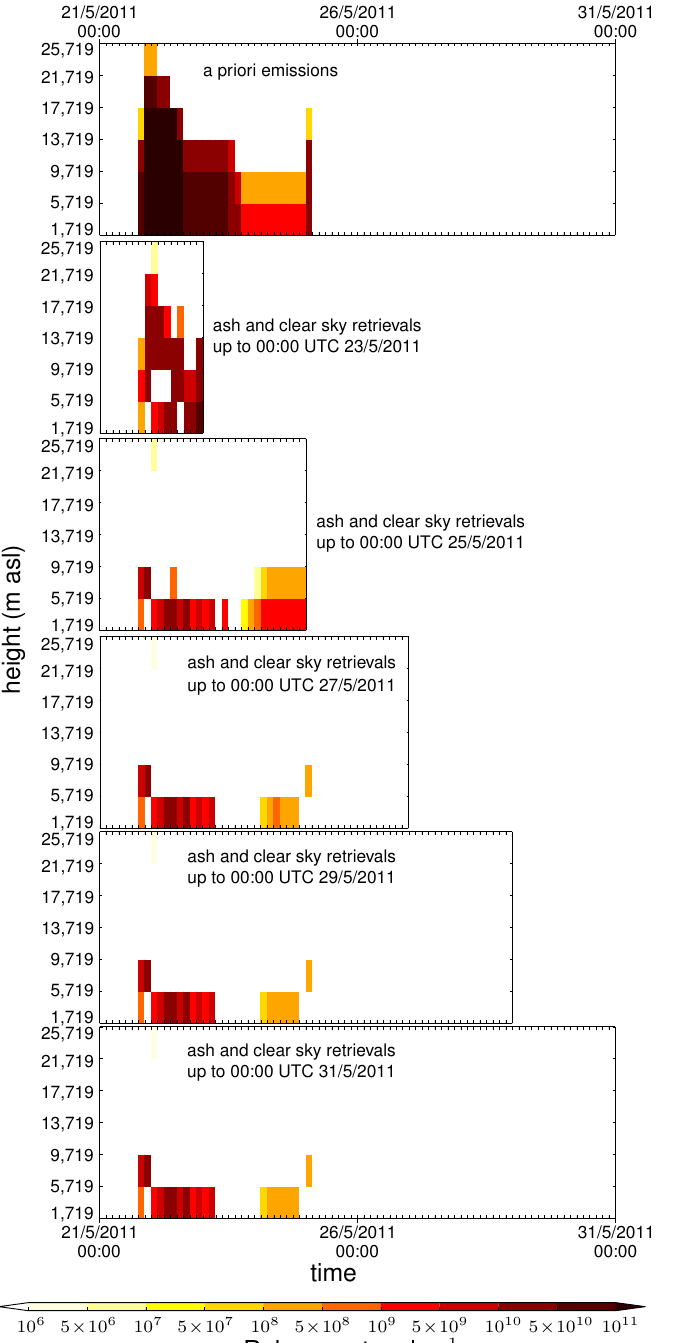
1.0e+06 5.0e+06 1.0e+07 5.0e+07 1.0e+08 5.0e+08 1.0e+09 5.0e+09 1.0e+10 5.0e+10 1.0e+11 Release rate g/hr